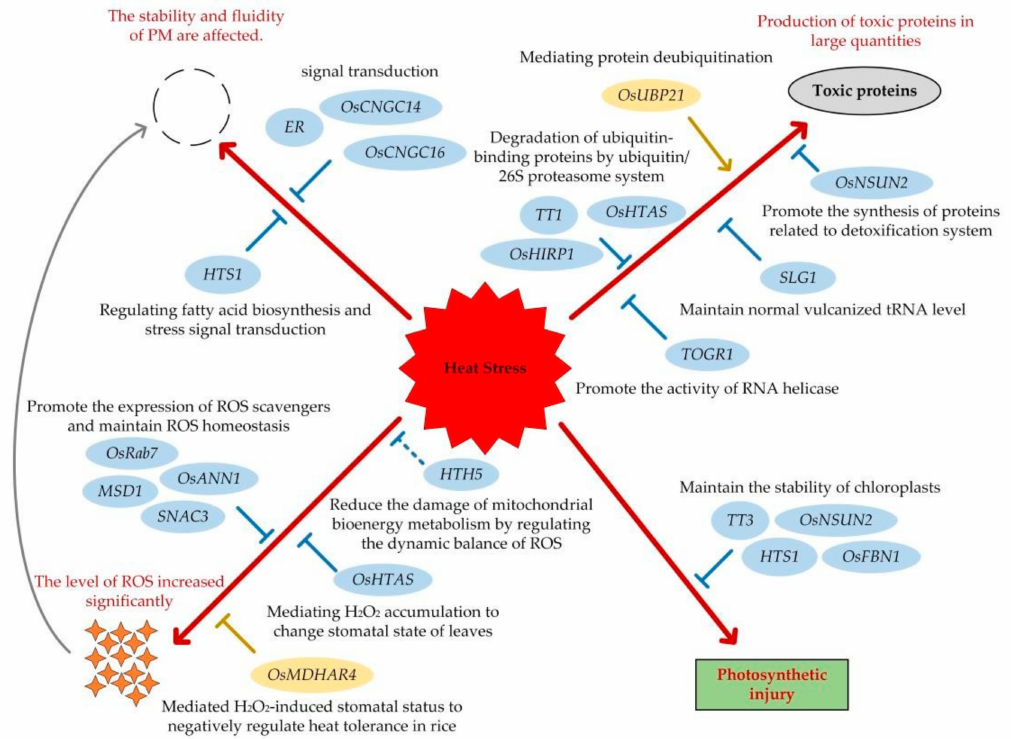
Figure 1. Molecular mechanism mediated by heat-tolerant genes in rice. HS mainly caused four major hazards to rice: the stability and fluidity of PM were affected, a large number of toxic proteins were produced, the level of ROS was significantly increased, and photosynthesis was damaged. Indeed, excessive ROS could also destroy the structure and function of the PM. ER , OsCNGC14 , and OsNGC16 improve the heat tolerance of rice through the signal transduction pathway. HTS1 enhances heat tolerance by regulating fatty acid biosynthesis and stress signal transduction. HTS1 , TT3 , OsFBN1 , and OsNSUN2 improve heat tolerance by maintaining chloroplast stability. OsNSUN2 , TOGR1 , and SLG1 improve heat tolerance by promoting the synthesis of proteins related to the interpretation system, promoting RNA helicase activity, and maintaining normal vulcanized tRNA levels, respectively. OsUBP21 negatively regulates heat tolerance by mediating protein deubiquitylation, while TT1 , OsHIRP1 , and OsHTAS degrade ubiquitin-binding proteins through the ubiquitin/26S proteasome system. OsHTAS and OsMDHAR4 regulate heat tolerance by mediating the stomatal state induced by H 2 O 2 . HTH5 may reduce the damage to mitochondrial metabolism under HS by regulating ROS homeostasis. OsANN1 , MSD1 , SNAC3 , and OsRab7 maintain ROS homeostasis by promoting the expression of ROS